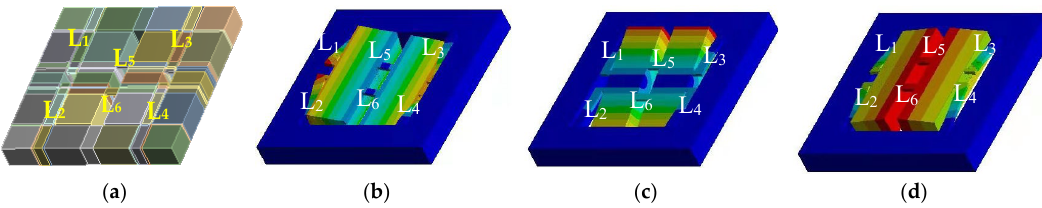
Figure 2. The deformation diagram of the chip under the acceleration along three-axis directions: ( a ) a x = a = a = 0 g; ( b ) a = a = a = a y z x ; ( c ) a y ; and ( d ) a z .